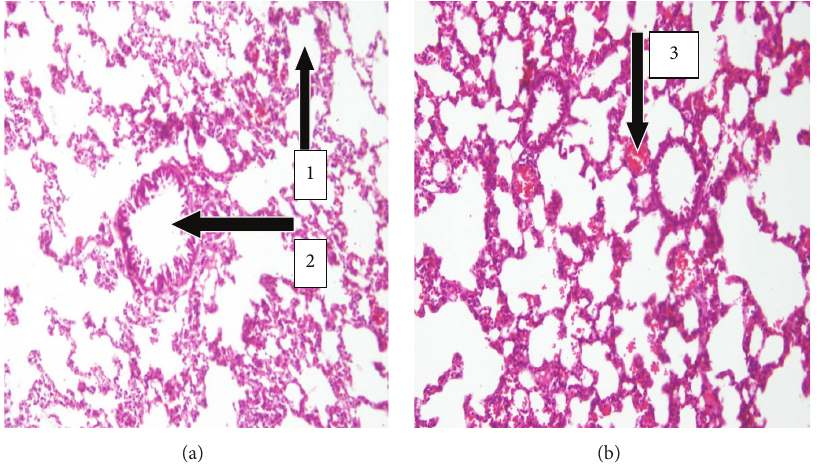
Figure 5: H&E stained sections of lungs at 20x magnification. (a) Lung sections of control rats showing normal histology. Note the presence of the alveoli with its surrounding interalveolar septa (1) , bronchus (2) , and pulmonary vessels with normal blood flow (3) . (b) Lung sections of treated animal (2000 mg/kg) showing normal structure of the bronchi and alveoli.